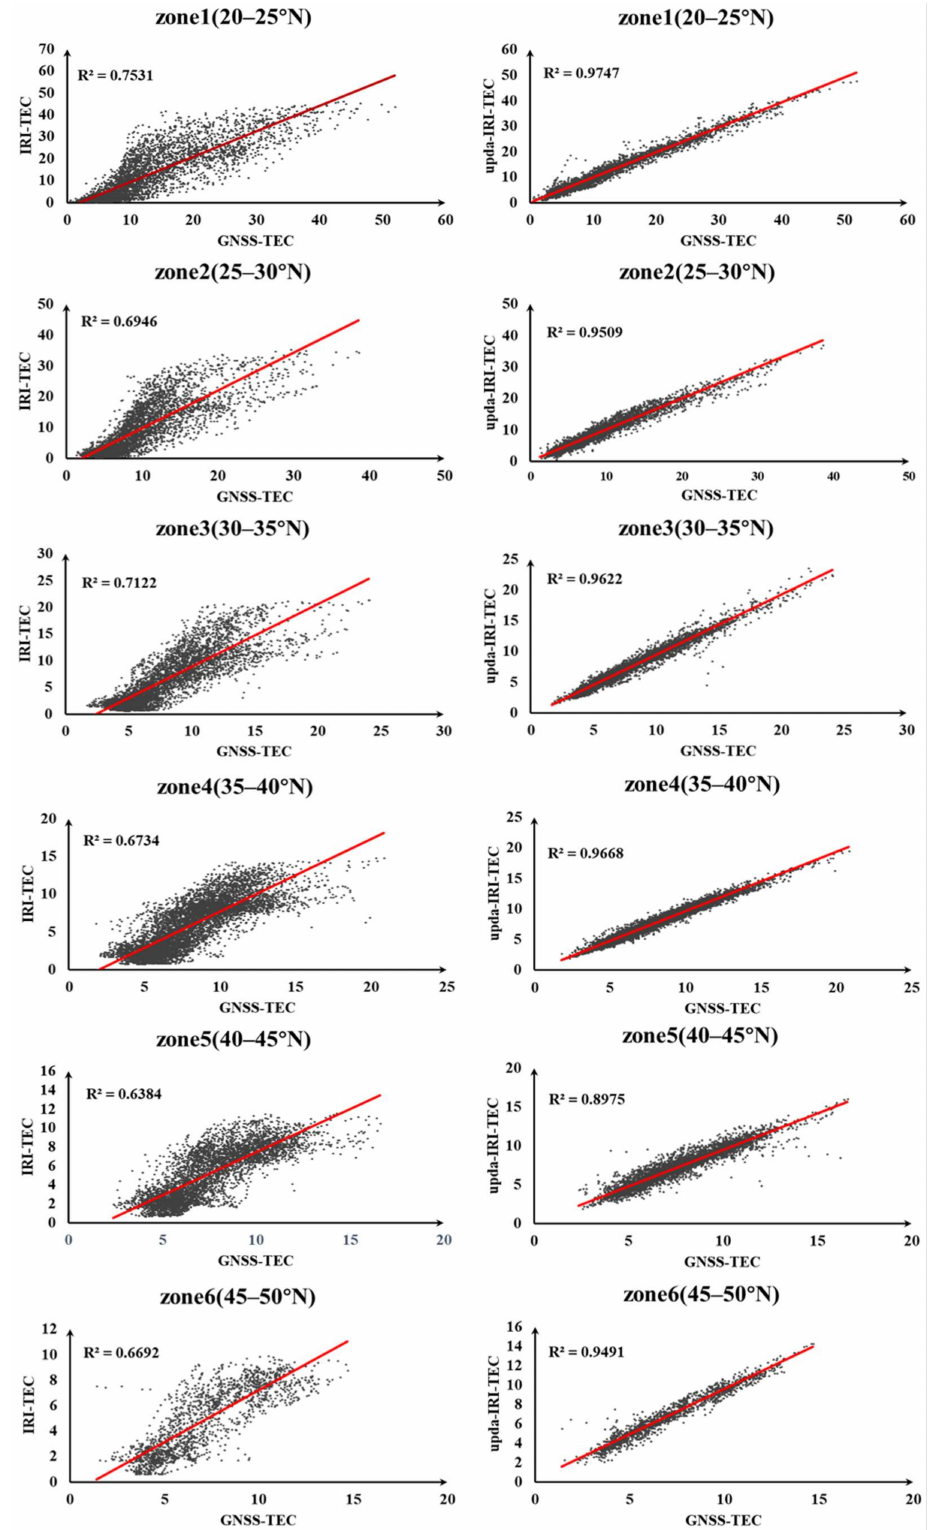
Figure 10. Linear regression diagrams between GNSS-TEC data from 2019 and the corresponding results of IRI-2016 and upda-IRI-2016 for 12 stations divided by